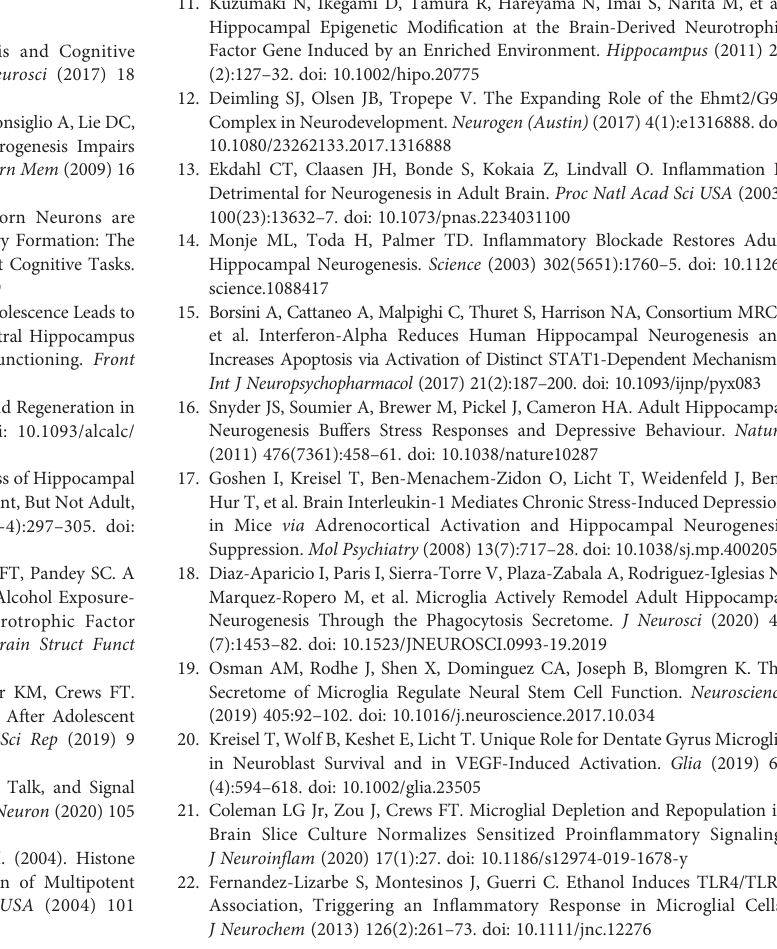
Supplementary Figure 1 | EtOH-EVs blunt IL-4 and UNC and BIX Inhibit G9a/ GLP activity. (A) OBSCs were treated with either pn-EVs, or EtOH-EVs for 96 hours. pn-EVs caused an 82% increase in IL-4 gene expression (one-way ANOVA, F 2,6 = 7.98, p < 0.0001). * p < 0.05, ** p < 0.01, **** p < 0.0001, Sidak ’ s post - test. (B) OBSCs were treated with EtOH-EVs for 96 hours +/- UNC (1µM) or BIX(500nM). H3K9me2 wasmeasuredinslices byIHC. A maineffect